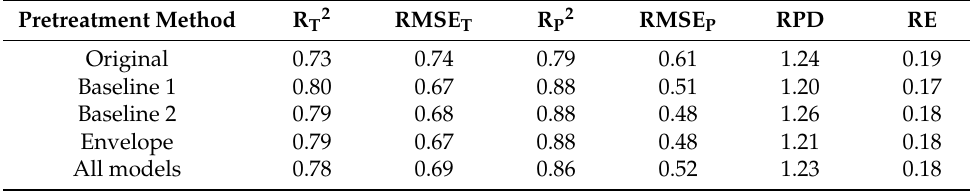
Table 3. Means of various combination